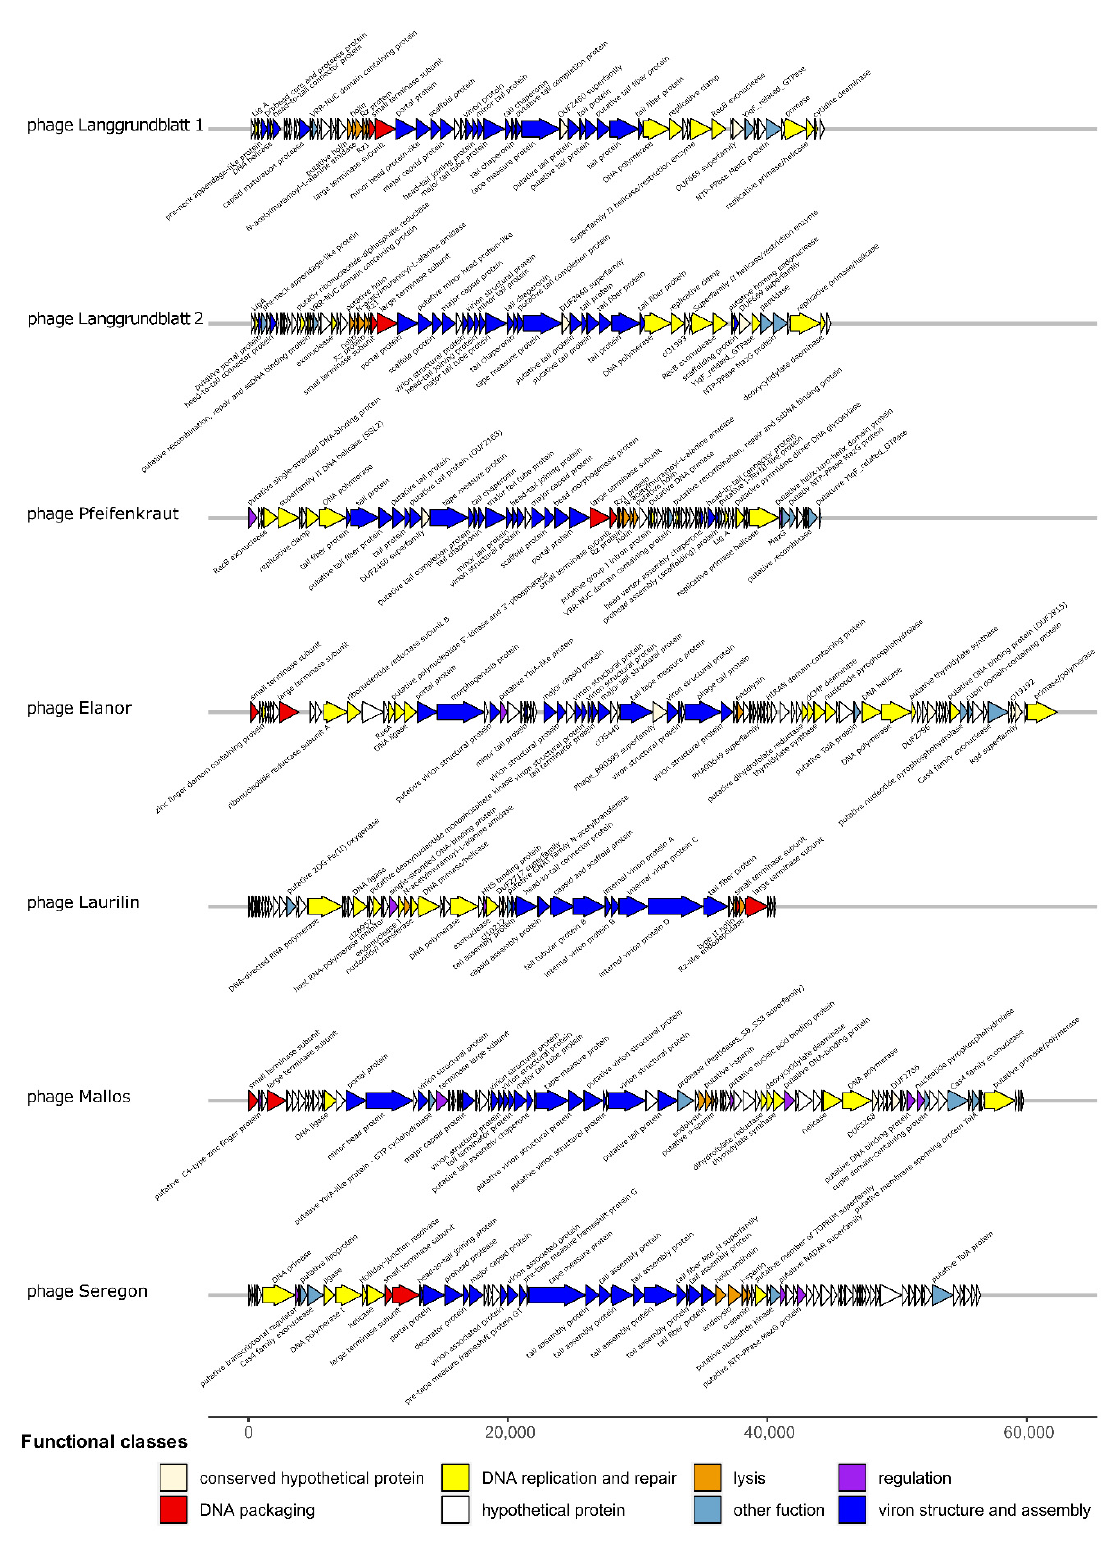
Figure 3. Genome map of the six Xanthomonas phages. Open reading frames (ORFs) were predicted using multiPhate [44], with Phanotate [42] and were later curated manually using NCBI Blast. Encoded protein domains were further predicted by using the batch function of NCBI Conserved Domain Database (CDD). Genome maps were created using the R package gggenes using fixed-length parameters.